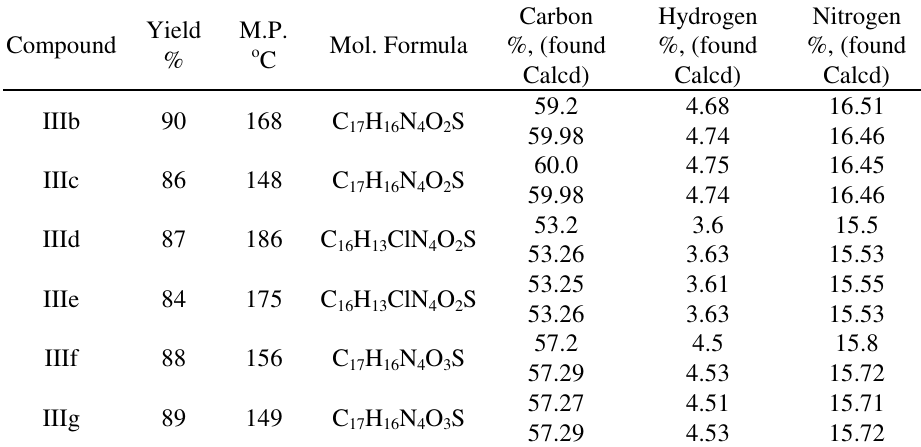
Table 4 . General characteristics and elemental analysis data of the compounds III